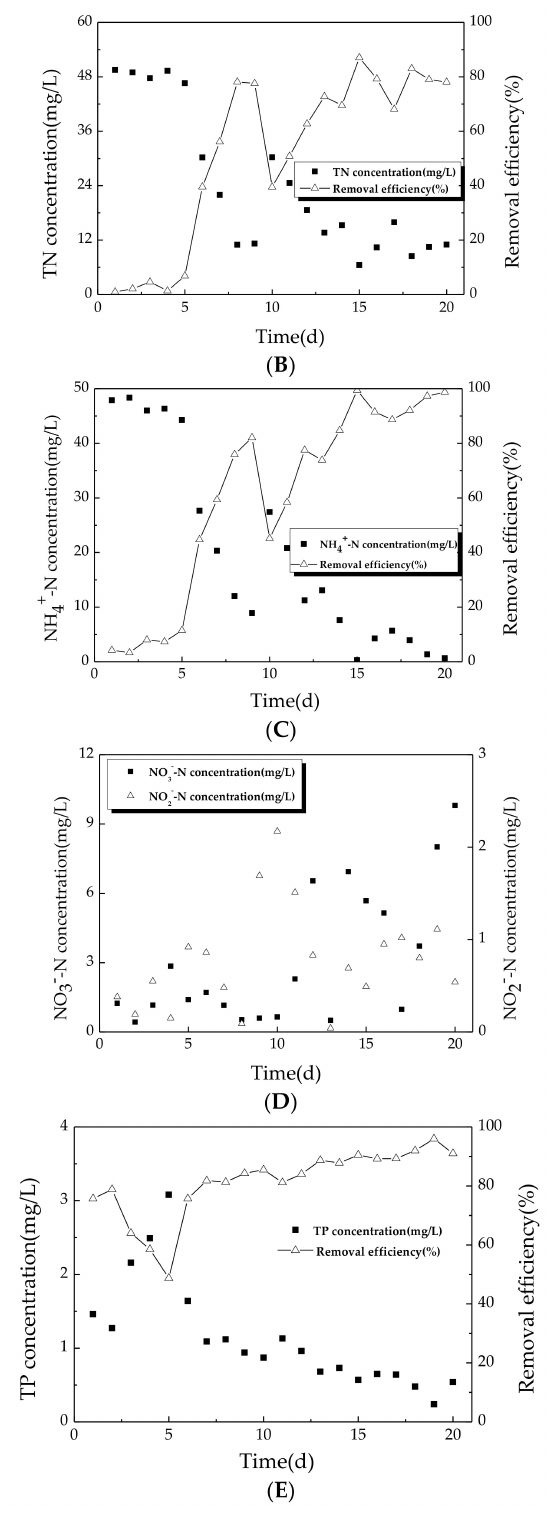
Figure 2. Performance of SBBR during start-up period: the effluent concentration and removal efficiency of COD (chemical oxygen demand), TN (total nitrogen), NH 4 + -N (ammonia nitrogen), and TP (total phosphorus), respectively ( A – E ); and the effluent concentration of NO 3 − -N (nitrate nitrogen) and NO 2 − -N (nitrite nitrogen) ( D ); the “d” refers to “day” in the horizontal axis